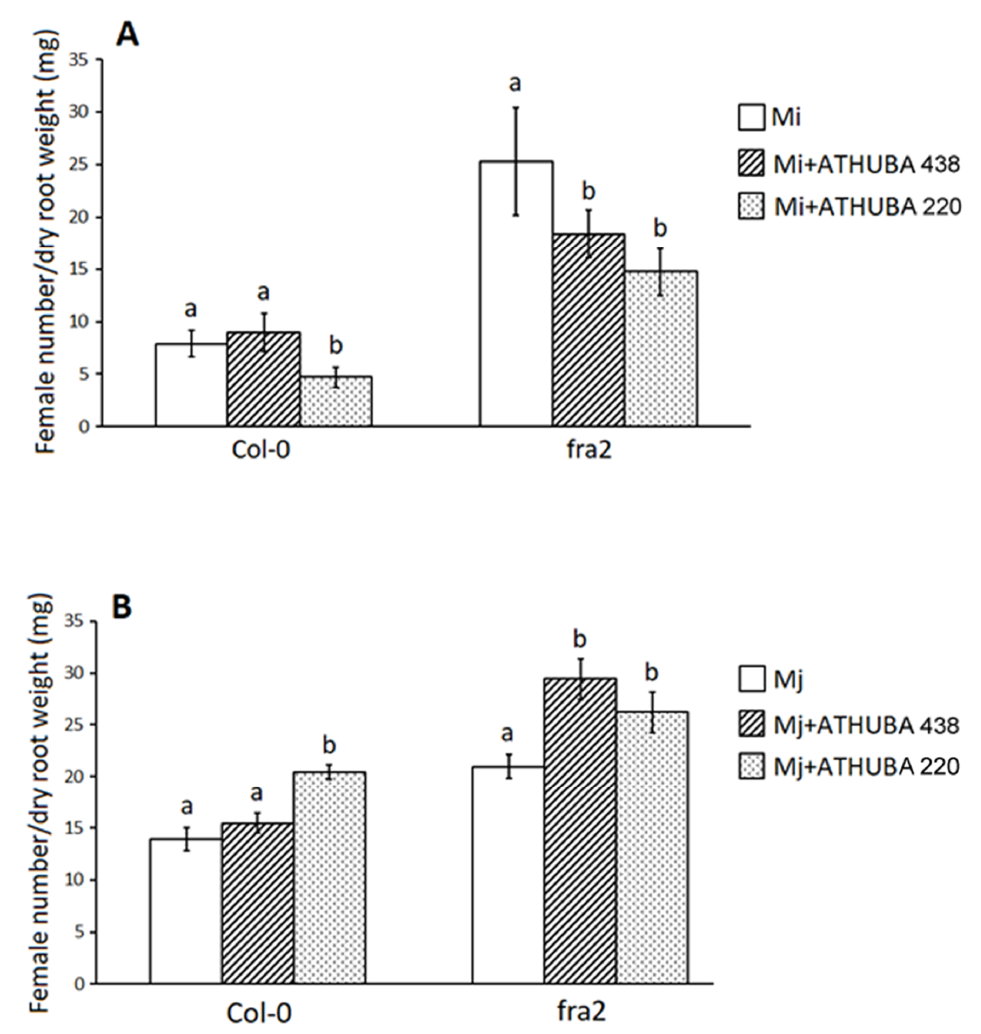
Figure 3. Arabidopsis thaliana L. plants (Col-0) and fra2 katanin mutants root infestation levels expressed as female number / dry root weight (mg) with M. incognita ( Mi ) ( A ) and M. javanica (Mj) ( B ) 45 Days after application of treatments. The treatments were performed with Streptomyces monomycini ATHUBA 220 and Streptomyces colombiensis ATHUBA 438 at 10 7 cells / g of soil. Di ff erent letters above columns correspond to statistically significant di ff erences between treatments (one-way ANOVA, Tukey’s test at p < 0.05; for all cases n =